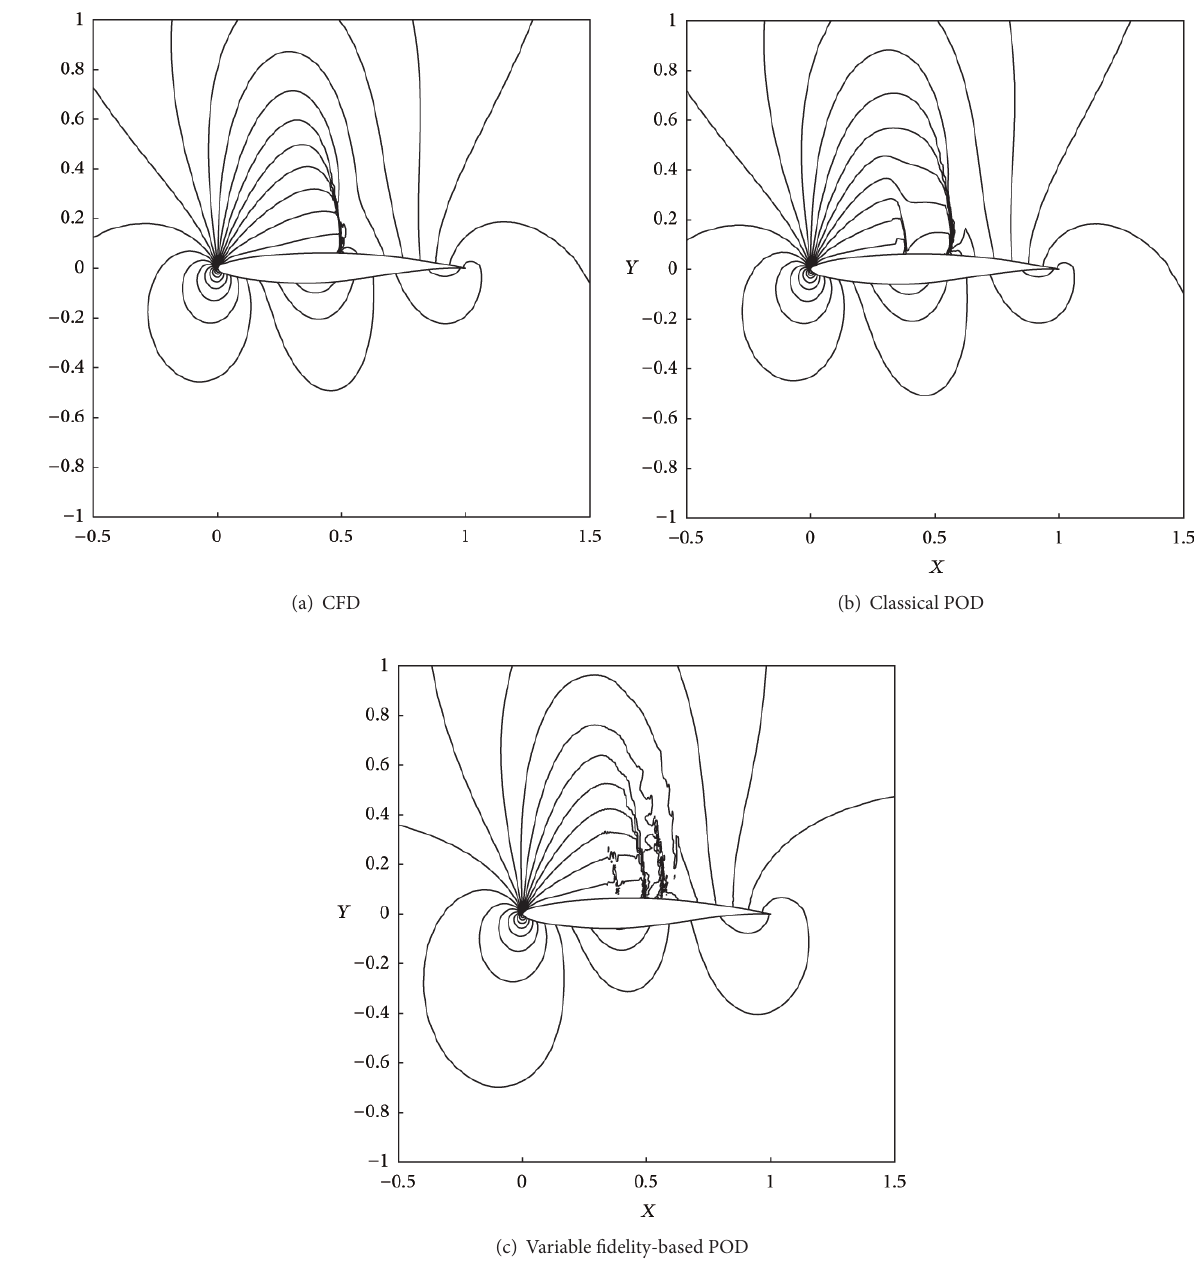
Figure 6: Comparison of the 3 contours of pressure at Mach = 0.7125 and A . O . A . = 3.375